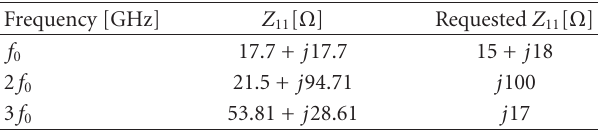
Figure 9: Geometry of the final layout: top view (a) and side view (b). The green rectangular area represents the DC feed, whereas the red rectangular pad represents the area where the PA output is to be soldered. Table 2: Final layout input impedance.